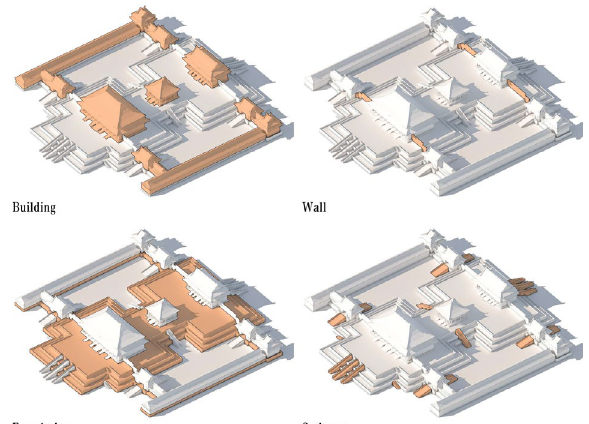
Figure 5. Four Categories of architectural elements in Taihe Palace